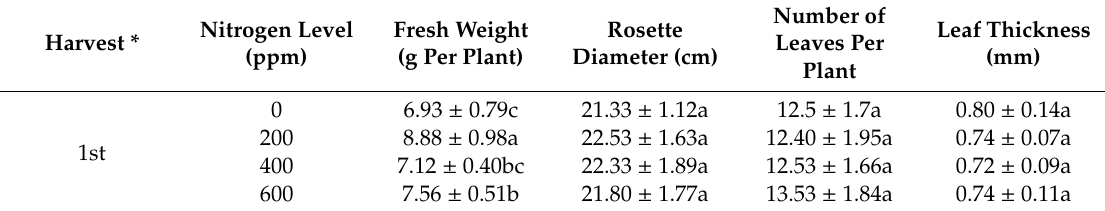
Table 1. Plant growth parameters of Centaurea raphanina subsp. mixta plants grown in 2 L pots under greenhouse conditions, in relation to harvesting time (1st harvest) and nitrogen level (0–600 ppm) (mean ± SD; n =